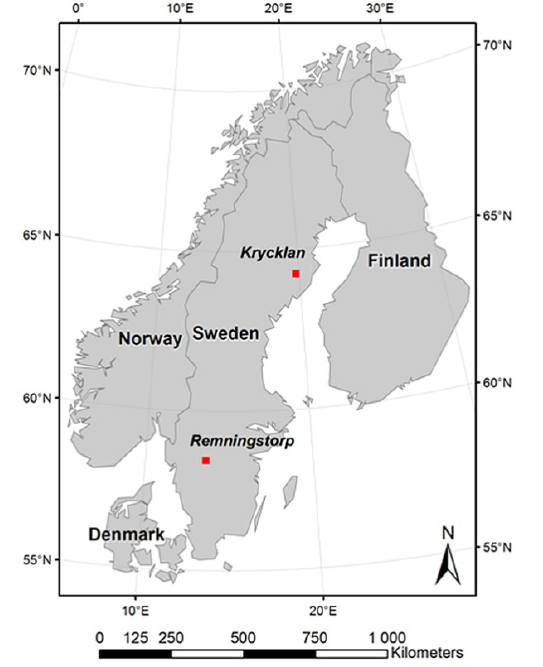
Figure 1. Map of Sweden showing the location of the two test sites of Remningstorp and Krycklan. The Krycklan test site (Figure 1) is located in the north of Sweden (64°14′N, 19°50′E) and is a watershed managed and owned by both Swedish forest companies and private owners. Topography is hilly with several gorges and the ground elevation ranges between 125 m and 350 m above sea level. The forest land covers about 6800 ha of mainly coniferous forests. The prevailing tree species are Norway spruce and Scots pine, but some deciduous tree species, e.g., birch ( Betula pubescens ), are also present. The forest is divided into stands of different sizes, occasionally being larger than 50 ha. Stem and consist mainly of either spruce or pine, or mixed species. In situ data consisted of digital stand boundary maps in vector format and stand-wise measurements of stem volume derived from forest field inventory